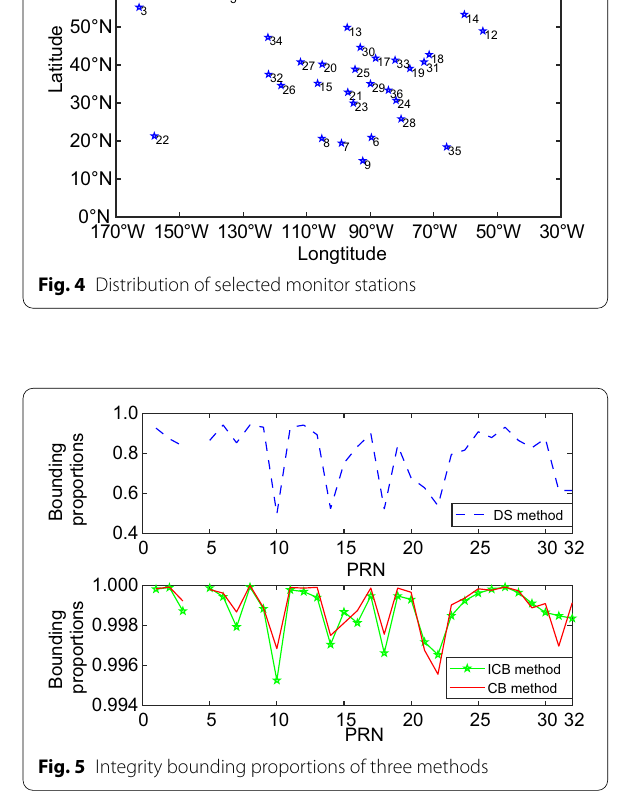
Fig. 7. The mean of the availability of DS method, ICB method and CB method is 91.26%, 96.40%, and 97.15%, respectively. The availability by ICB method is 5.63%